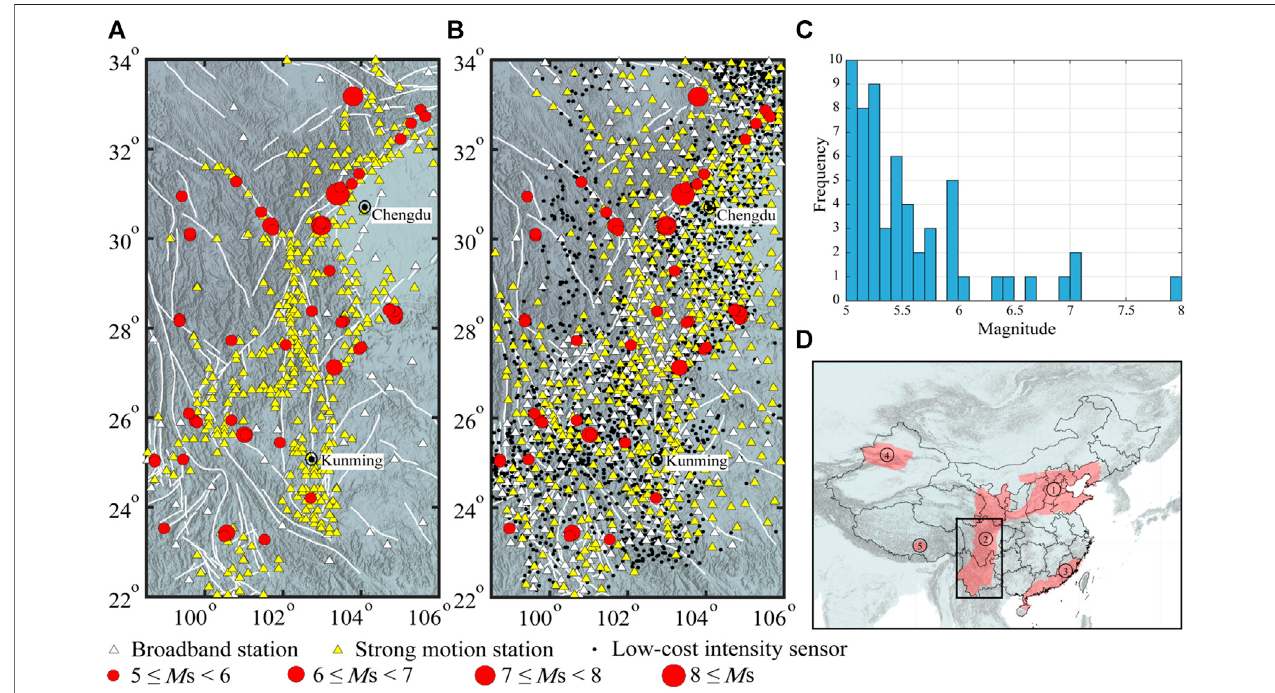
FIGURE 1 | (A) Existing (as of 2018) and (B) planned (as of 2022) stations, deployed or upgraded as part of the National System for Fast Report of Intensities and Earthquake Early Warning of Chinese mainland. Red dots show the epicenters (from China Earthquake Networks Center, CENC) of the 2008 M S 8.0 Wenchuan and 57 5.0 ≤ M S < 7.0 earthquakes studied in this paper. White lines show the fault locations. (C) Magnitude distribution of earthquakes shown in (A) and (B) . (D) The larger tectonicsettingwiththe fi vekeyEEWregions:1)northChina,2)centralChinanorth-southseismicbelt,3)southeastcoast,4)middlesectionofTianshanMountains of Xinjiang, and 5) Lhasa of